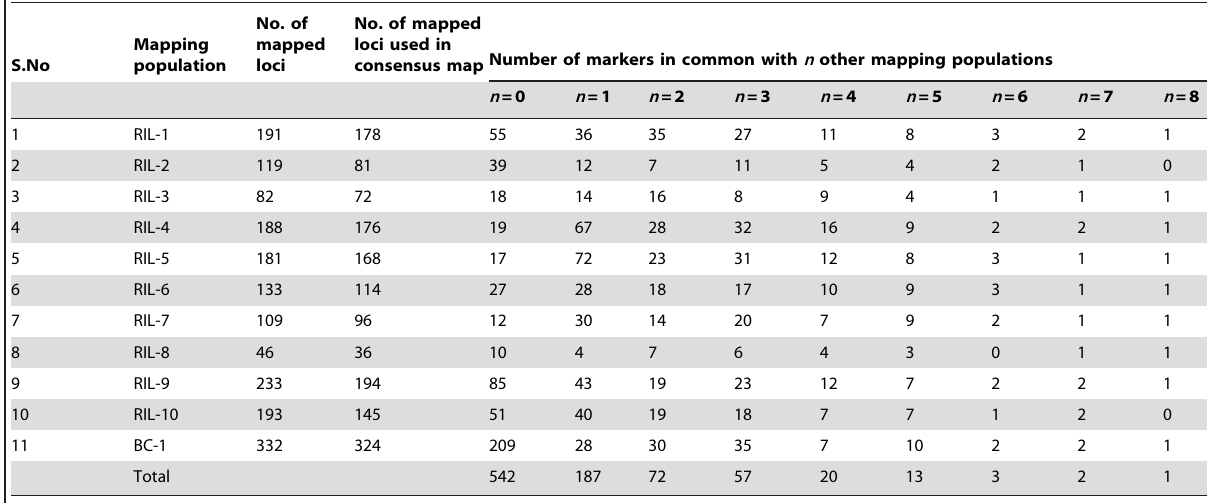
Table 3. Summary of number of loci common between genetic maps for different mapping